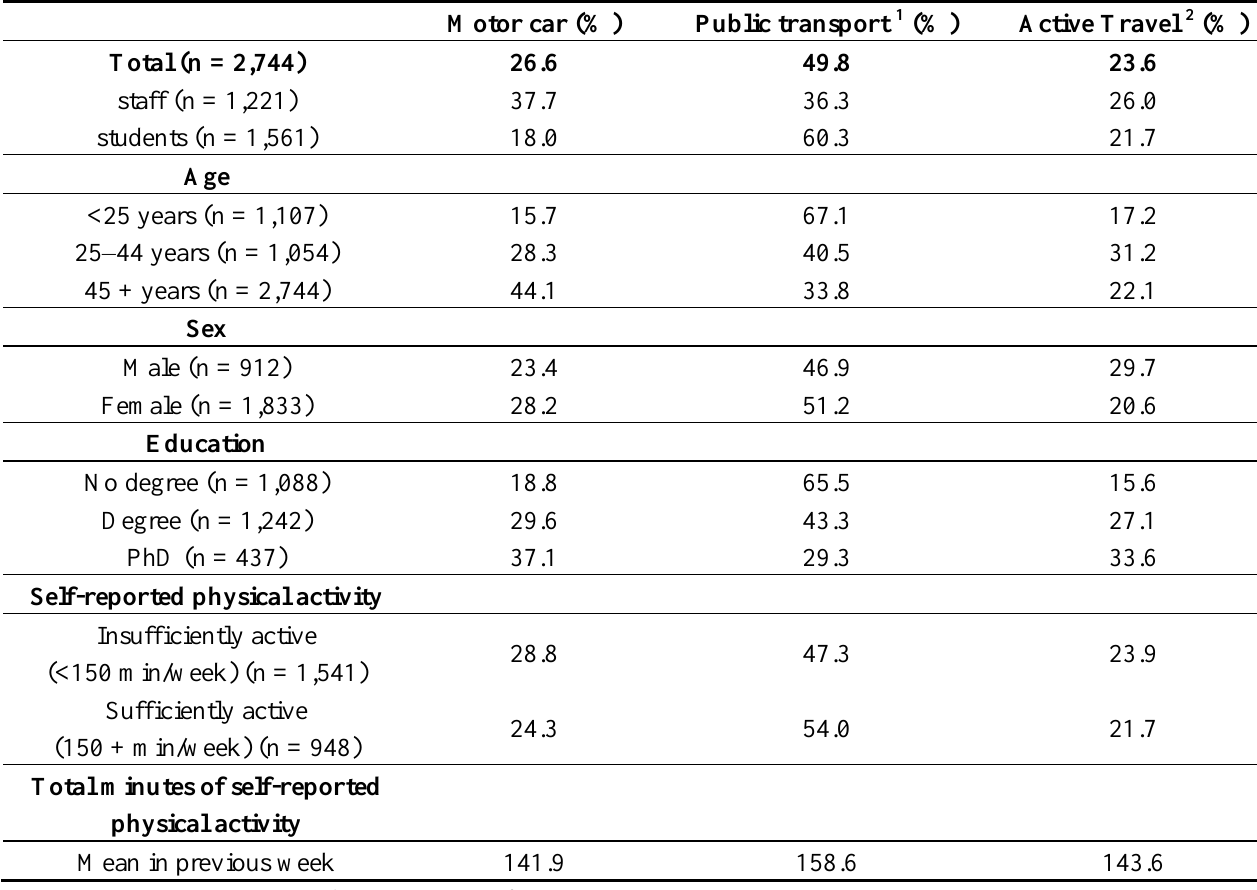
Table 3. Travel mode by staff/student